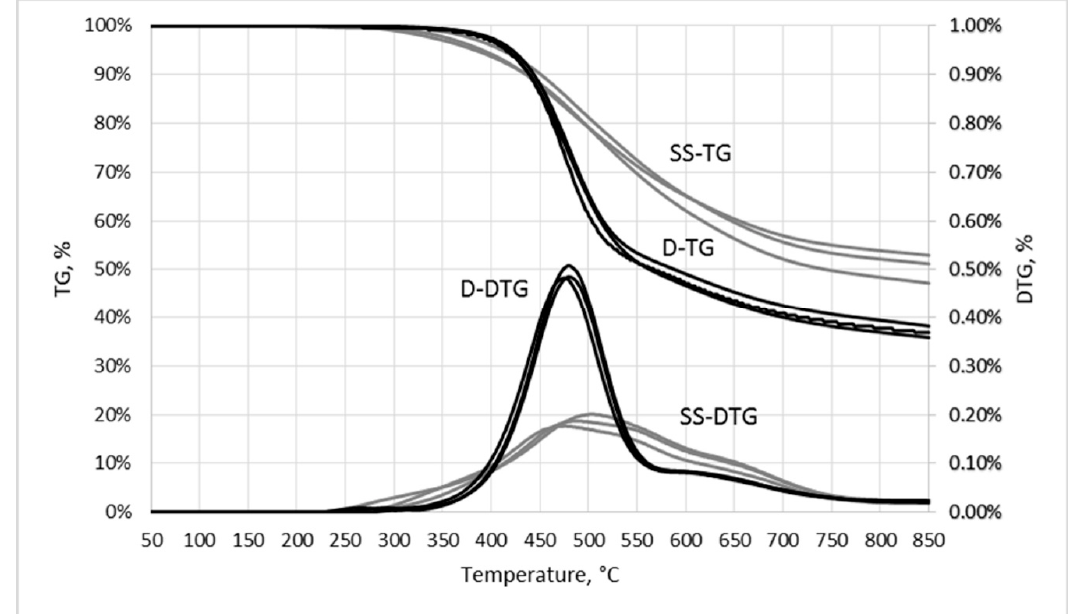
Figure 14. The thermogravimetric characteristic of sewage sludge (SS) and digestate (D) heated from 50 °C to 850 °C.